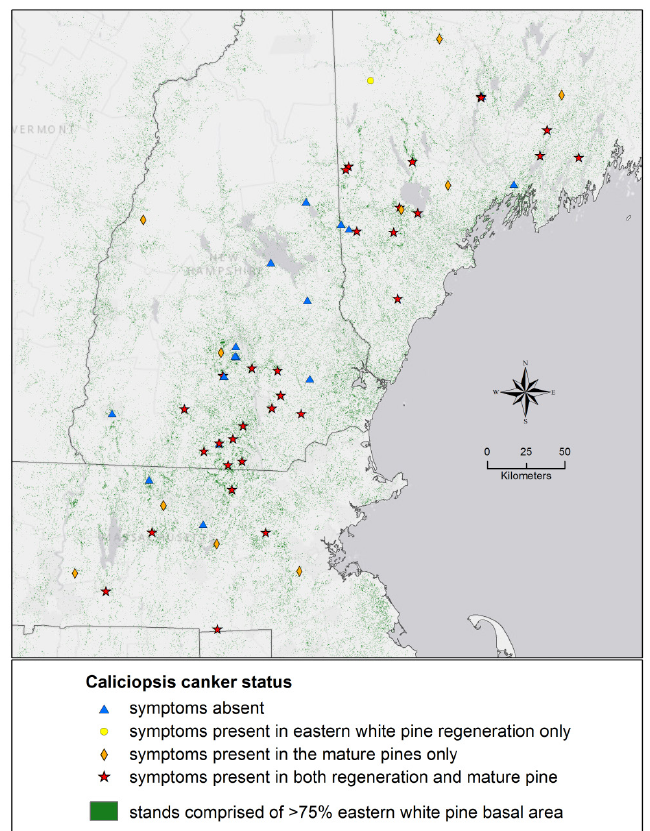
Figure 2. Location of 58 sites sampled in Maine, Massachusetts, and New Hampshire during 2014 and the presence of Caliciopsis canker symptoms at those